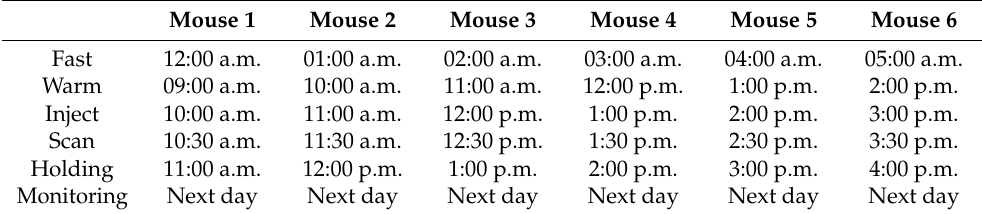
Table 1. A typical experimental workflow for PET scan of a group of 6